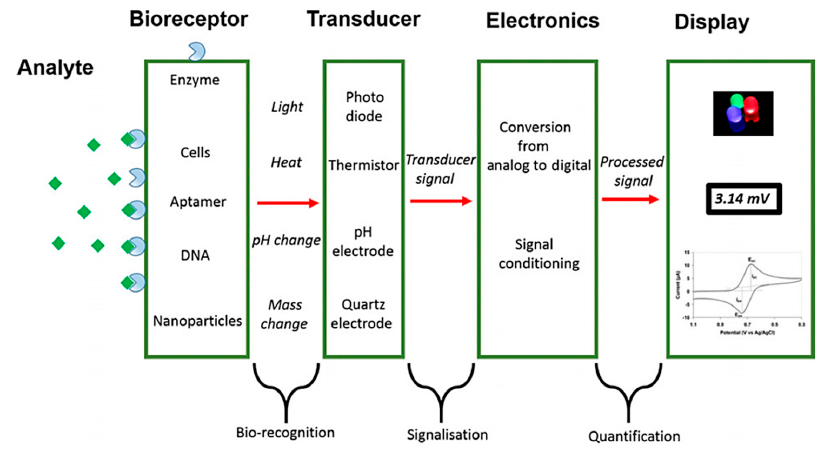
Figure 8. Standard components of a biosensing device. (Re-printed from Bhalla et al. [89]. Copyright (2016)).